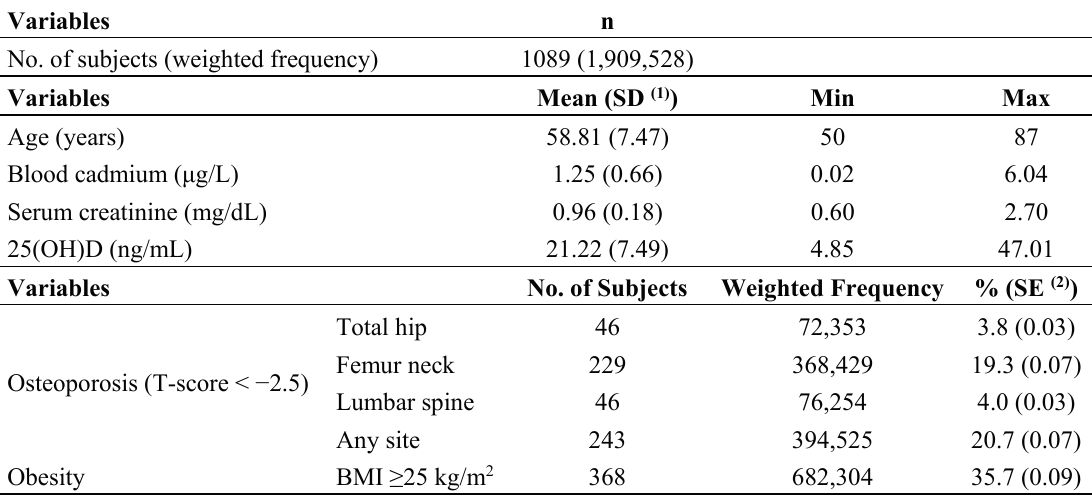
Table 1. General characteristics of the study